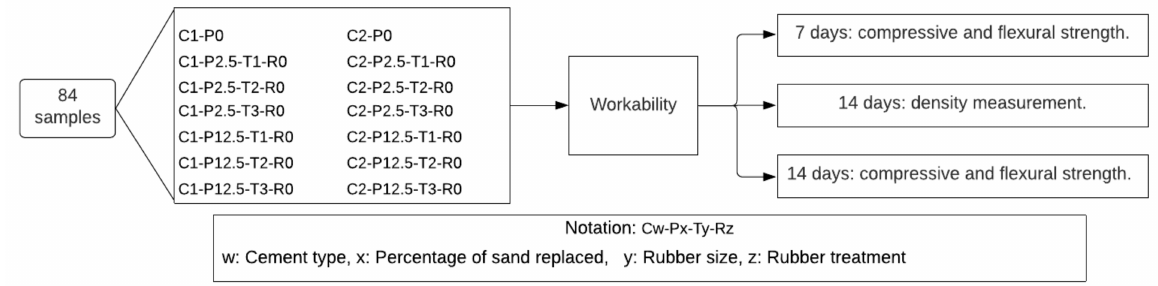
Figure 1. Experimental plan description of stage 1.